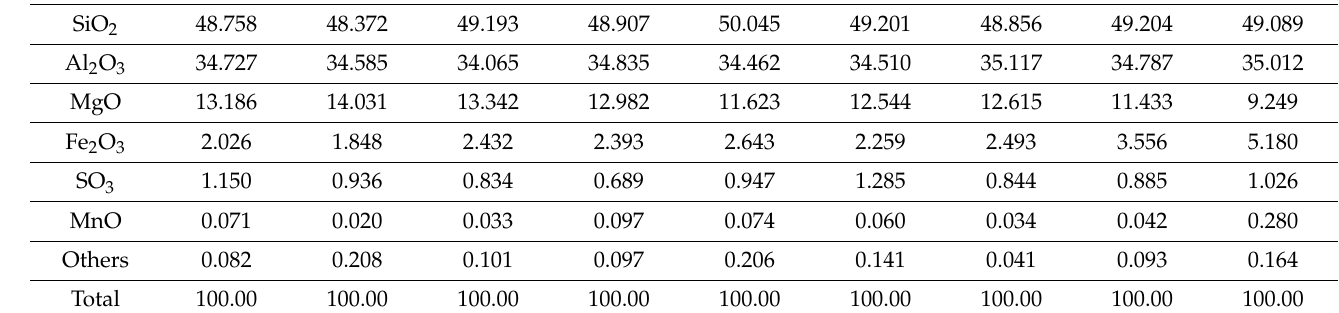
Table 2. The ED ‐ XRF data of iolites.